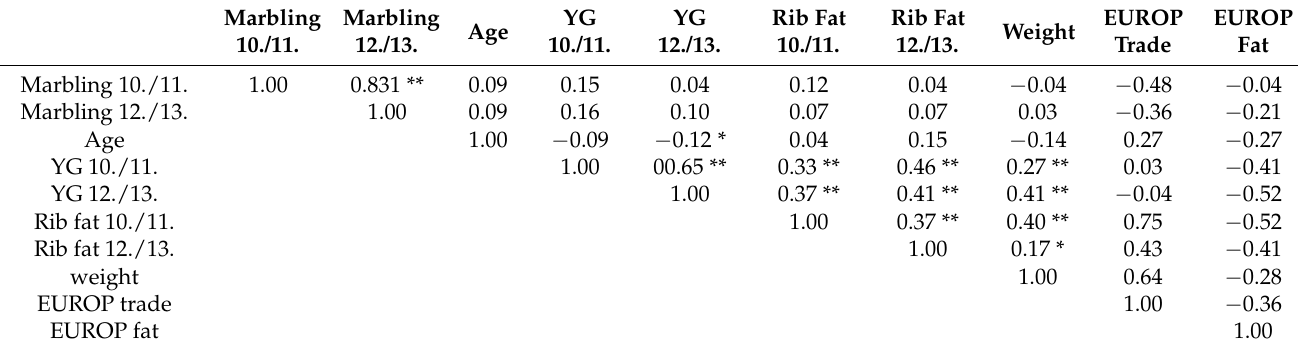
Table 2. Pearson correlation coefficients of the assessed carcass